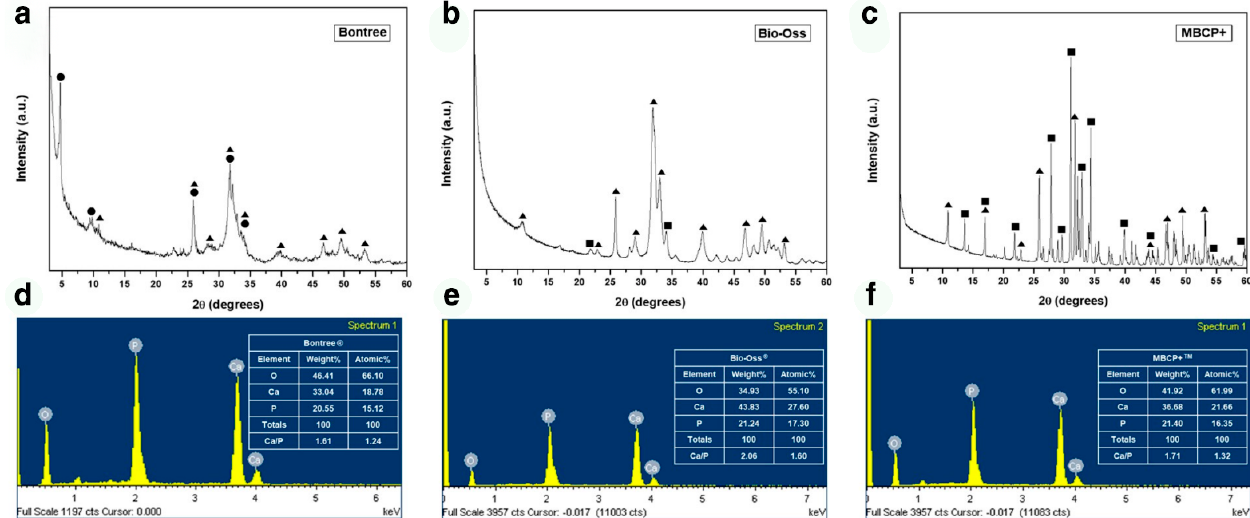
Figure 2. Results of XRD analysis ( a – c ) and EDS analysis ( d – f ). OCP samples ( a , d ) consisted of mainly OCP phase. BHA samples ( b , e ) consisted of HA phase, and BCP samples ( c , f ) consisted of HA and β -TCP phases. The OCP, HA, and β -TCP peaks are indicated by ● , ▲ , and ■ , respectively.